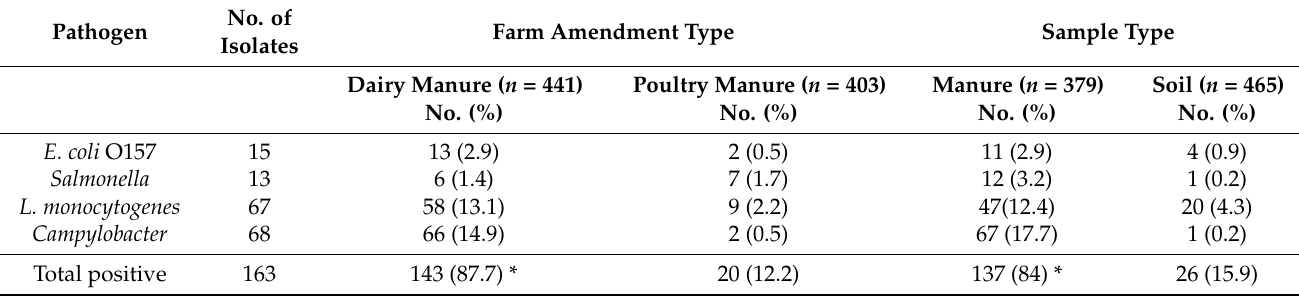
Table 2. Prevalence of foodborne pathogen from different